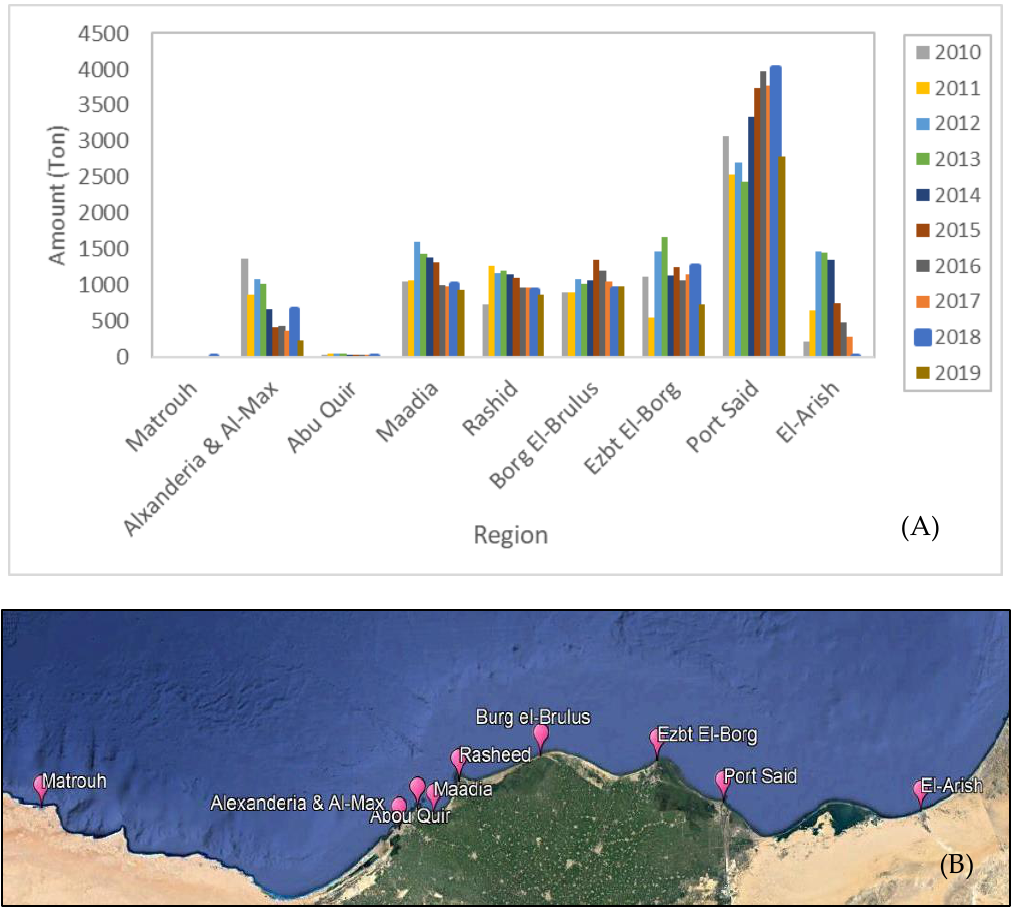
Figure 10. ( A ) The annual sardine catches along the north coast according to ( B ) the landing site from Matrouh to El-Arish from 2010 to 2019.